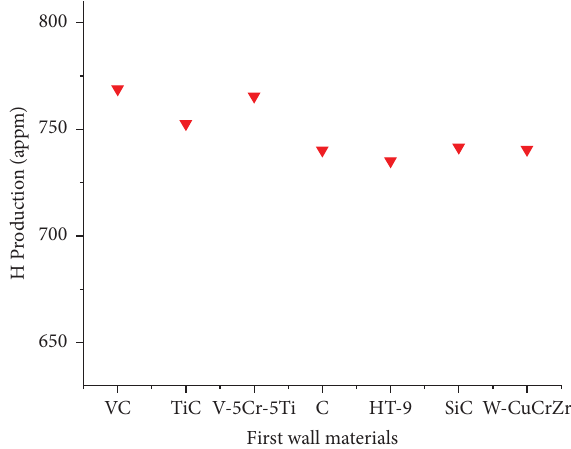
Figure 14: Hydrogen production in each candidate FW